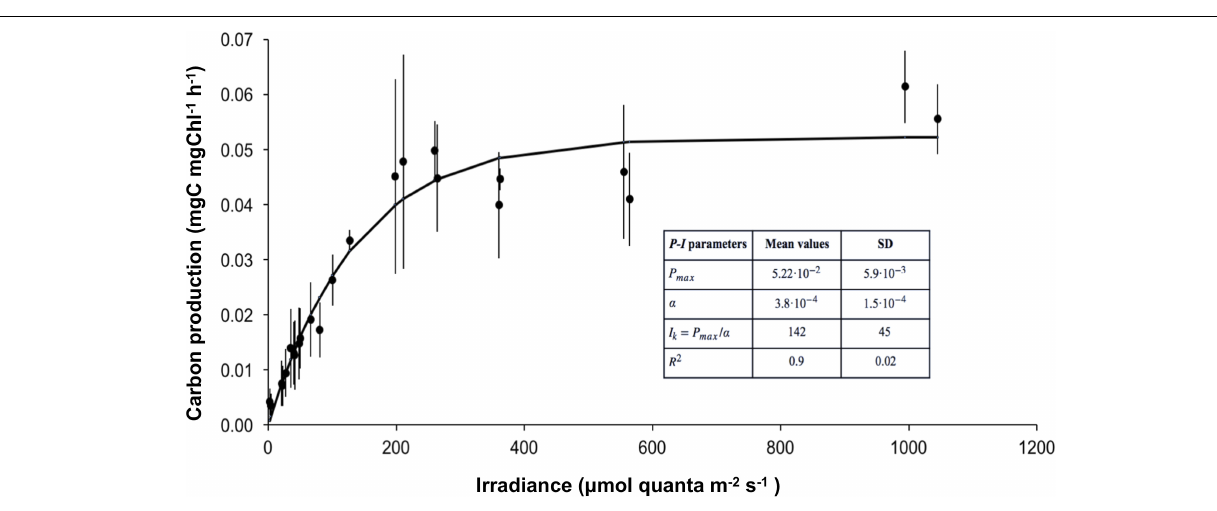
cloud cover. Hence, the jellyfish will respond to changes in the vertical water column by choosing a depth to match their optimal physiological tolerance and maximize